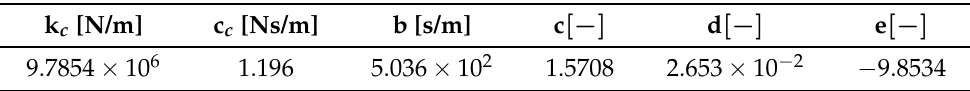
Table 2. Pacejka friction model